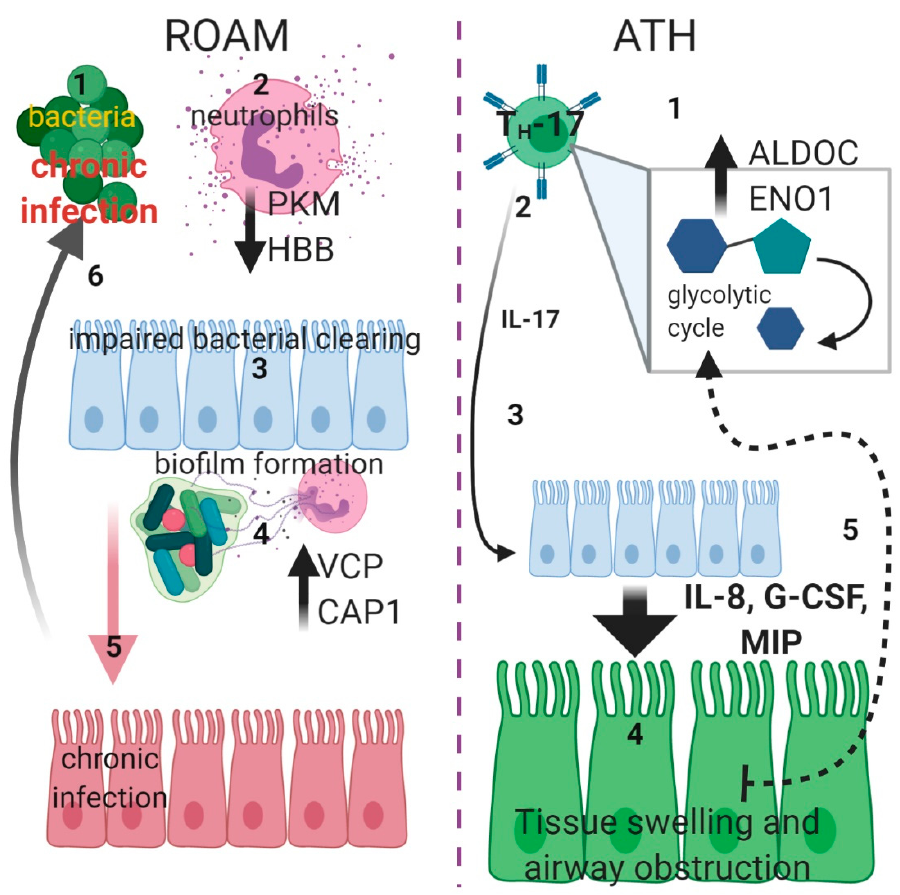
Figure 7. Schematic diagram displaying putative pathogenic mechanisms In ROAM (left side): bacterial infections (1) triggers neutrophils degranulation (2), but this is not effective due to lower PKM and HBB levels (black arrow downwards). Defective bacterial clearing (3) causes chronic infection (through formation of biofilm) in the median ear, with a consequent increase of NETs formation (4), due to higher proteasome activity provoked by increased VCP and CAP1 levels (black arrow upwards). Chronic bacterial infection of ear tissue (5) (red) establishes a milieu in which recurrent infections (6) are facilitated. In ATH (right side), TH ‐ 17 cells are activated (1) and switch to glycolytic metabolism (gray square), with increased levels of ALDOC and ENO1 (black arrow upwards). Activation of these cells causes increasing Interleukin ‐ 17 (IL ‐ 17) (2) production. This cytokine (3) could drive epithelial expression of granulopoietic and chemotactic factors such as Interleukin ‐ 8 (IL ‐ 8), Granulocyte Colony ‐ Stimulating Factor (G ‐ CSF) and Macrophage Inflammatory Proteins (MIP) (big arrow downwards) that could induce swelling of adenoidal tissue (4) (green), followed by upper airway obstruction. The imperfect oxygen intake could then trigger a self ‐ sustained cycle (5) (dotted arrow), inducing furthermore a switch toward glycolytic metabolism (created with BioRender.com).